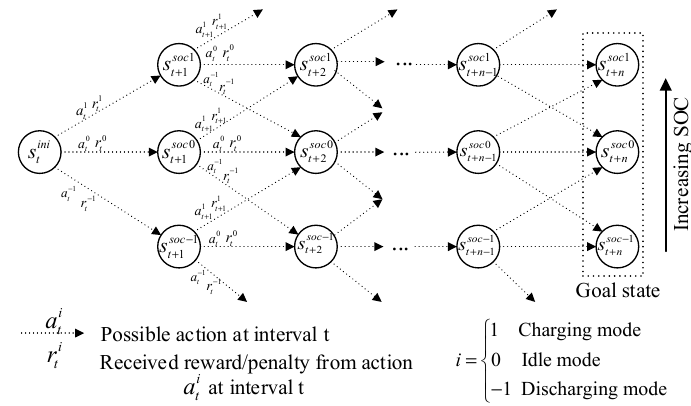
Figure 3. Possible states and actions of a community battery storage system (CBESS).